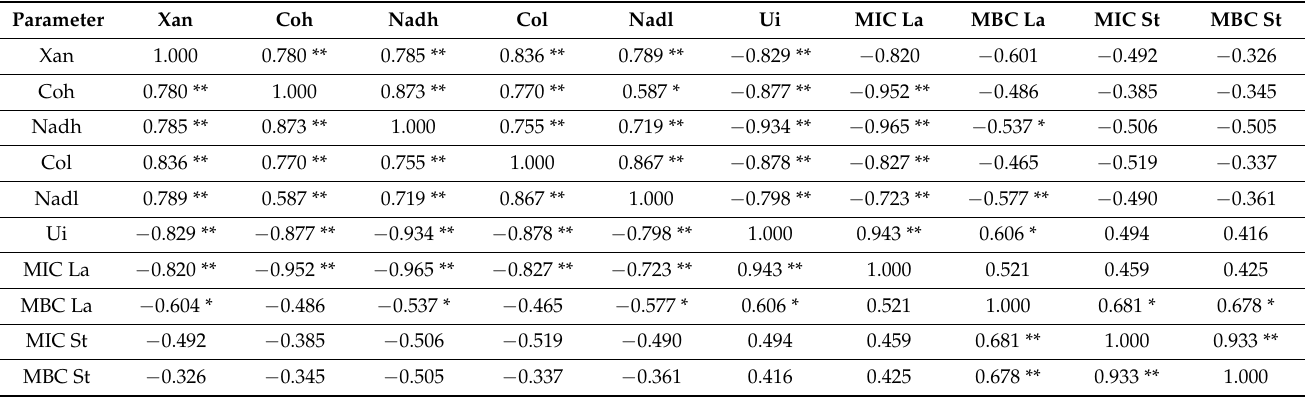
Table 6. Spearman’s rank correlation coefficients (R) between chemical parameters and antimicrobial properties of hop